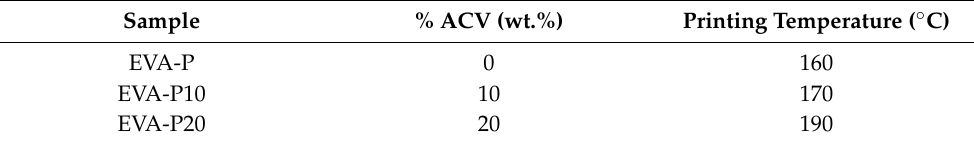
Table 1. Printing temperatures of EVA and EVA/ACV devices.